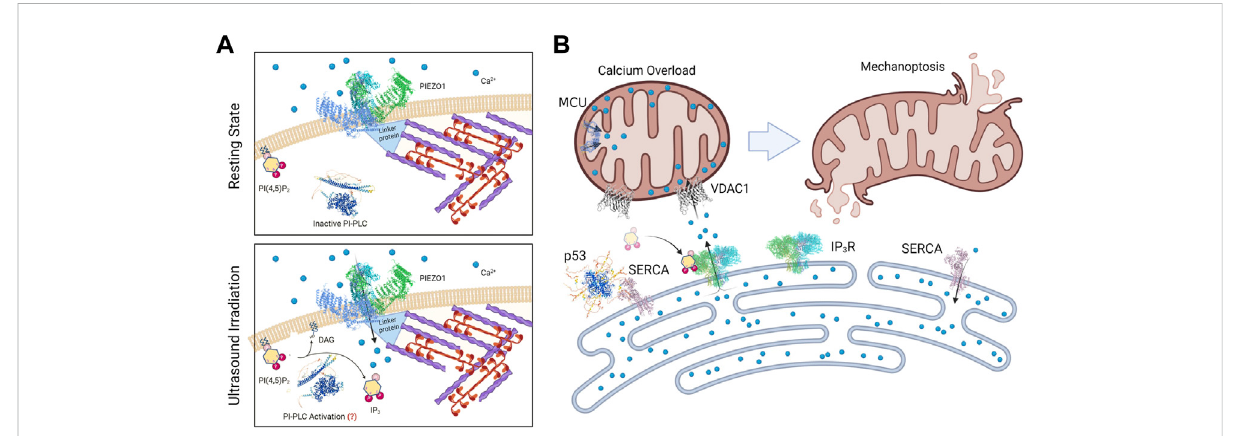
FIGURE 2 Diagrams of a working model for Mechanoptosis of transformed growth cells. In (A) the Piezo1 channel is shown in complex with cytoplasmic proteins that are linked to an actomyosin network that needs to be active for mechanoptosis. In the lower panel the hydrolysis of PIP2 is shown to produce IP3 although the mechanism of activation of phosphatidyl inositol phospholipase C (PI-PLC) is not understood nor is the link to Piezo1 activity.In (B) therise inIP3levelactivates thereleaseofERcalciumbytheIP3receptorthat islinkedto theVDAC channel, causing arise in mitochondrial calcium levels leading to apoptosis. The ER calcium pump, SERCA is shown in complex with p53 at these sites.